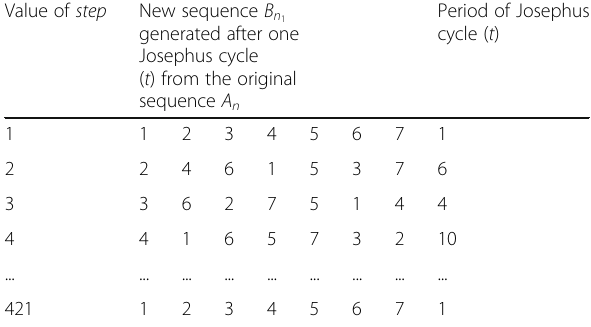
Table 4 Josephus cycle state of each step value in experiment 4 Value of step New sequence B n Period of Josephus 1 generated after one cycle ( t ) Josephus cycle ( t ) from the original sequence A n